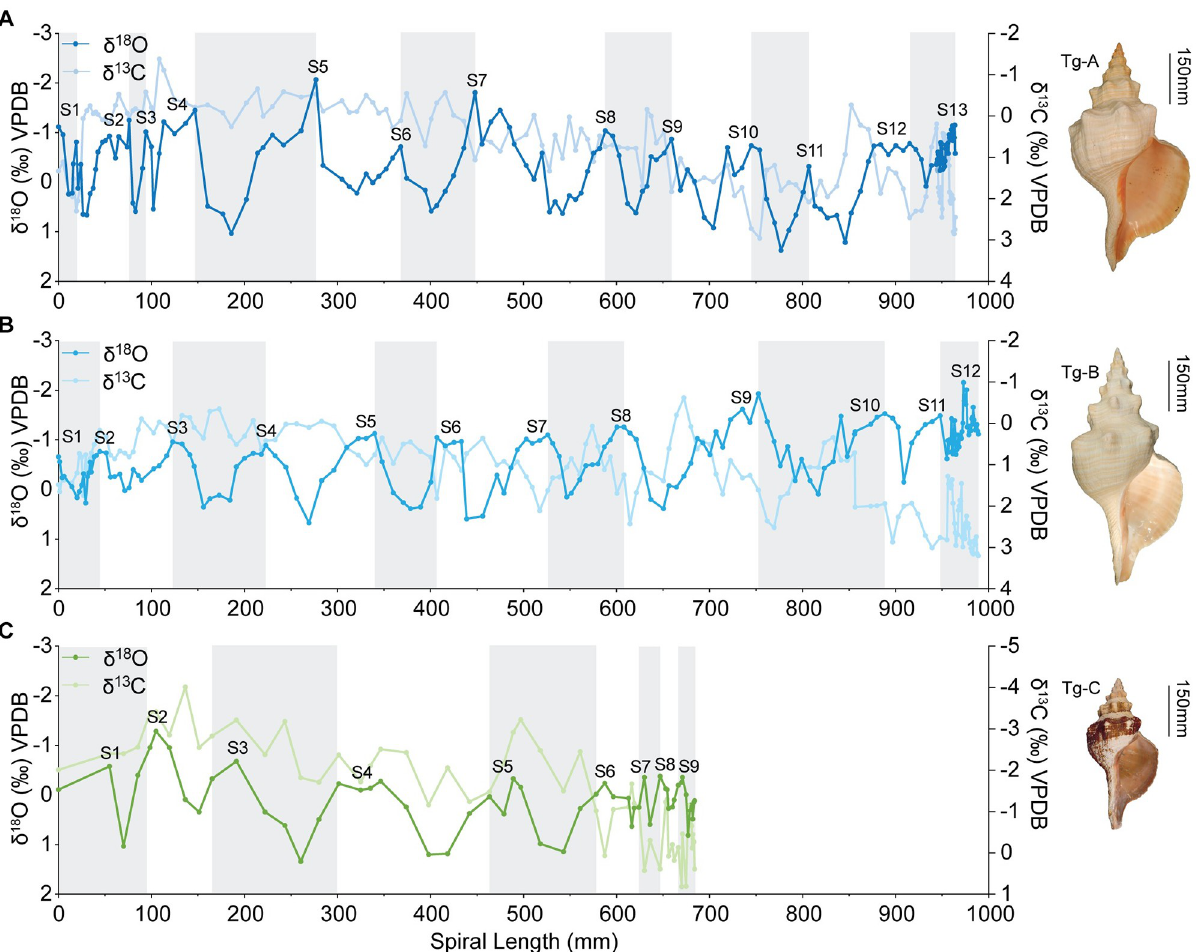
Fig 2. Stable oxygen and carbon isotope profiles. Oxygen (darker lines) and carbon (lighter lines) stable isotope sclerochronology profiles for Triplofusus giganteus shells. A. Specimen Tg-A (BMSM 119422) from the Dry Tortugas, Florida Keys. B. Specimen Tg-B (BMSM 119423) from Vaca Key, Florida Keys. C. Specimen Tg-C from Cape Romano, Florida. Positions of summers (S) are indicated at cycle peaks. Years are shown as alternating grey and white bands. Line colors correspond to growth curve colors in Fig